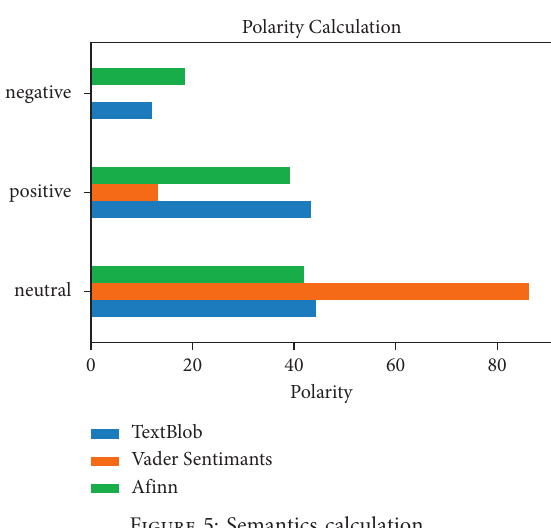
Figure 5: Semantics calculation.